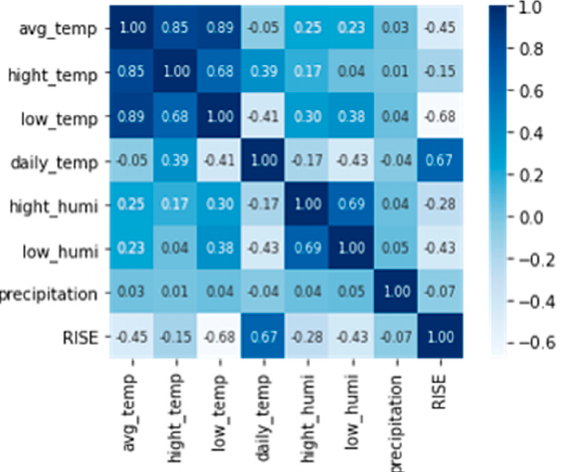
Figure 15. The analysis results based on the interpretations of Pearson’s correlation coefficients between the environmental elements and Acer mono sap yield.